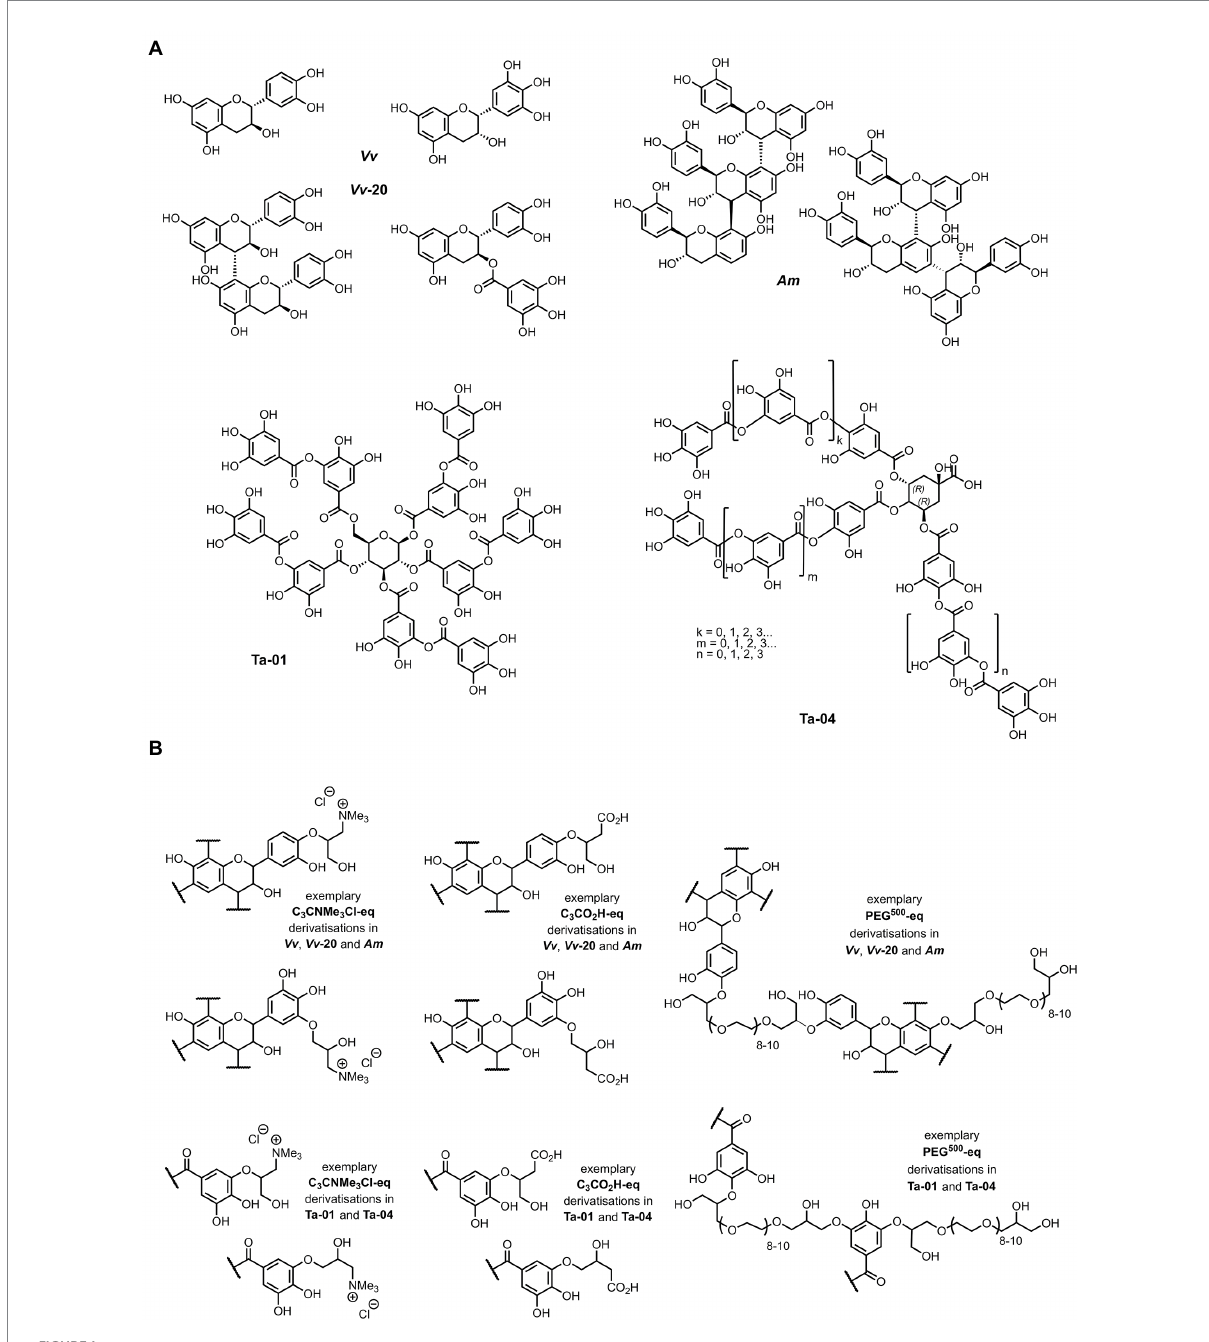
FIGURE 1 (A) Chemical structure of commercially available condensed and hydrolysable tannins used in this study (40) and (B) their chemically derivatized structures as described elsewhere (41). Exemplary structural aspects are shown; synthetic route leads to generation of both primary and secondary aliphatic alcohols within the total C 3 linker moiety connecting the functional to the tannin (41). (i) C 3 NMe 3 Cl-eq – hydroxy- N , N , N - trimethylpropanyl-3-aminium chloride; (ii) C 3 COOH-eq – hydroxypropyl-1-carboxylic acid; and (iii) PEG 500 -eq – oligomeric ethylene glycol polyether (PEG 500